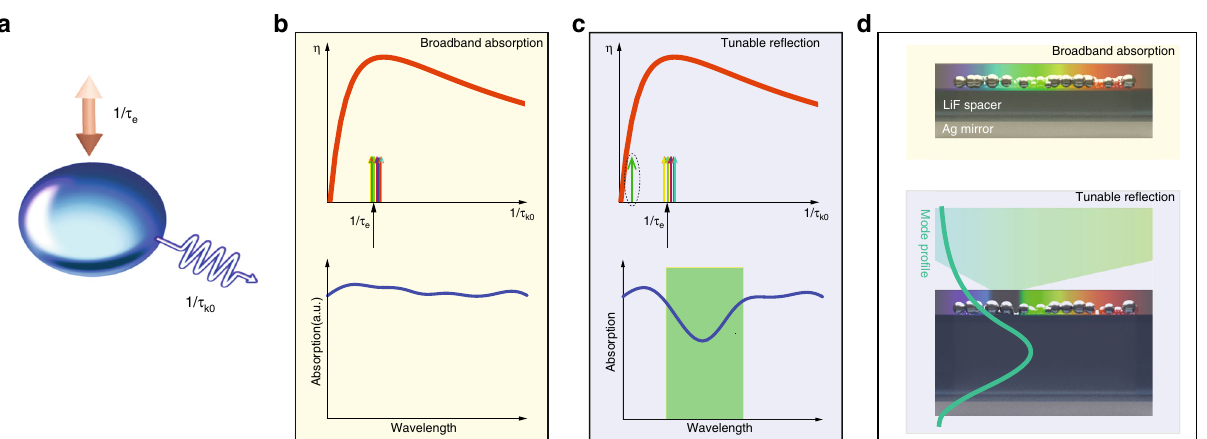
Fig. 1 A disordered system with transition from broadband absorption to band-limited re fl ection/transmission based on coupled mode theory. a Schematic for a generalised optical cavity with coupling rate τ e and intrinsic decay rate τ k 0 for the k th mode supported. b Broadband absorption regime. Upper panel: the disorder induces the convergence of intrinsic decay rates, leading to energy equipartition with similar coupling ef fi ciency η for all the modes. Lower panel: broad absorption is achieved, computed with 25 modes with τ k 0 converging within [0.8, 1.2] τ e . c Band-limited regime. Upper panel: sudden reduction of intrinsic loss of a speci fi c mode; lower panel: an absorption dip is formed by enlarging the intrinsic decay τ k 0 (by 20) of speci fi c mode. d A realistic design matching the CMT model, composed of a disordered plasmonic system on a cavity with plasmonic mirror beneath. The thickness t can tune the intrinsic decay rate of a speci fi c mode, driving the system from a broadband absorption (upper panel, t is too small to hold a mode) to band- limited re fl ection (upper panel, with a mode con fi ned around the plasmonic